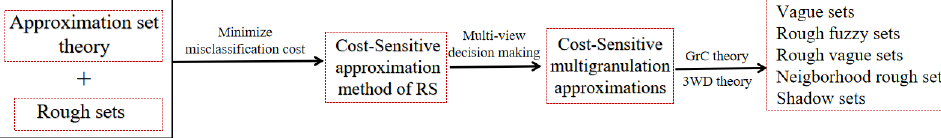
Figure 7. Diagram of works conducted in this